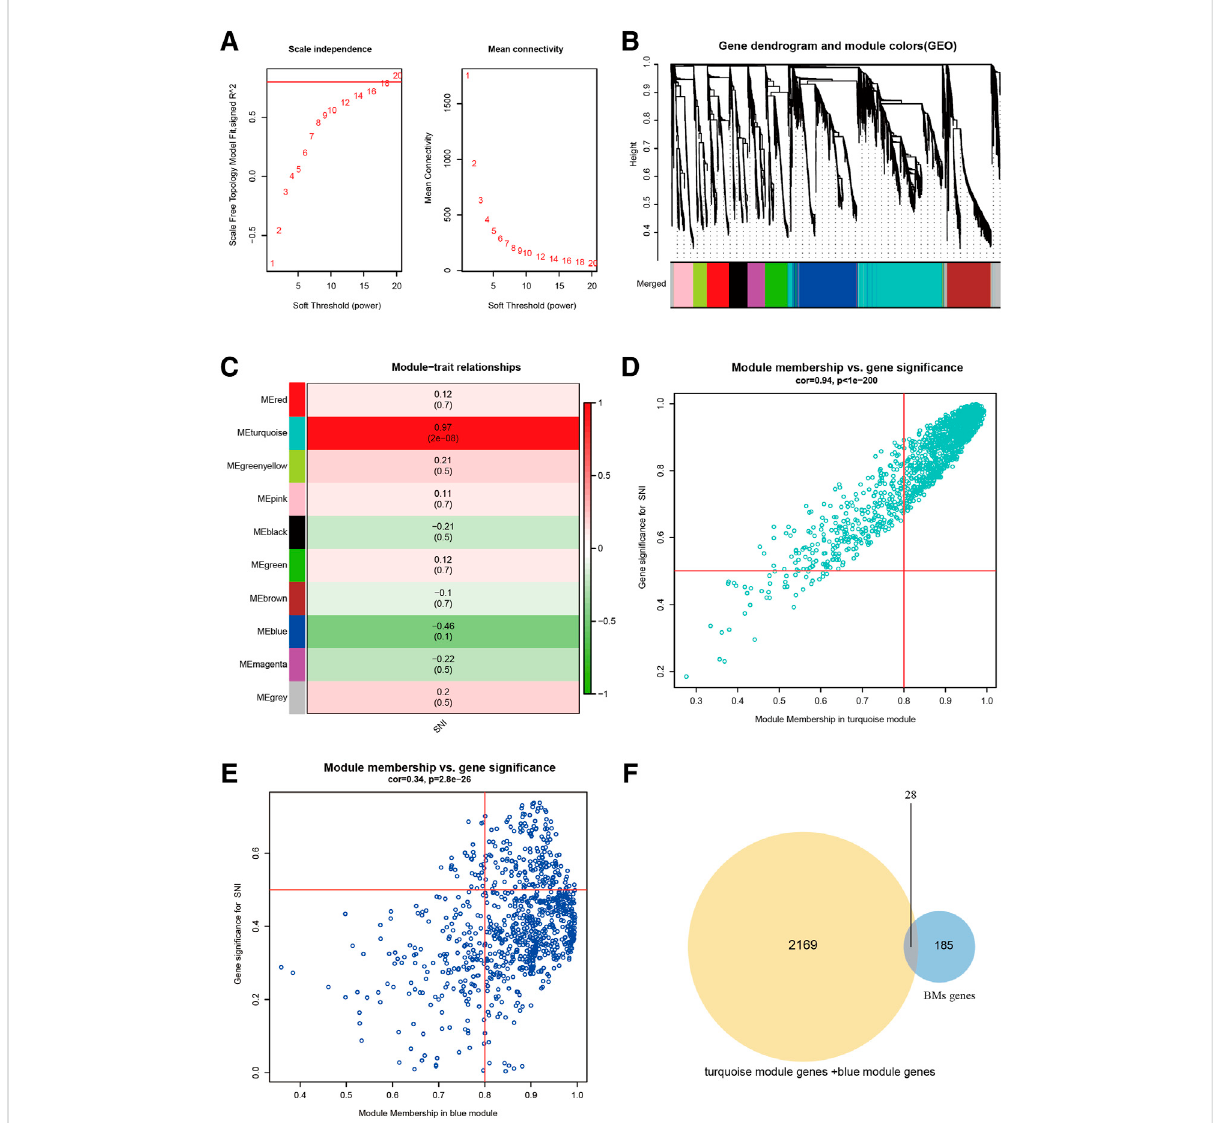
FIGURE 1 ScreeningofchiefmoduleandBM-linkedgenes. (A) SoftthresholdsettingwithparameterR2=0.80. (B) The6modules-basedseparationofthe geneset. (C) The modules versusSNIincidenceassociation. (D) The turquoise moduleversusSNIgene signi fi cancecorrelation. (E) The blue module and SNI gene signi fi cance relationship. (F) The Venn plot of two gene sets, BMs, turquoise + blue module